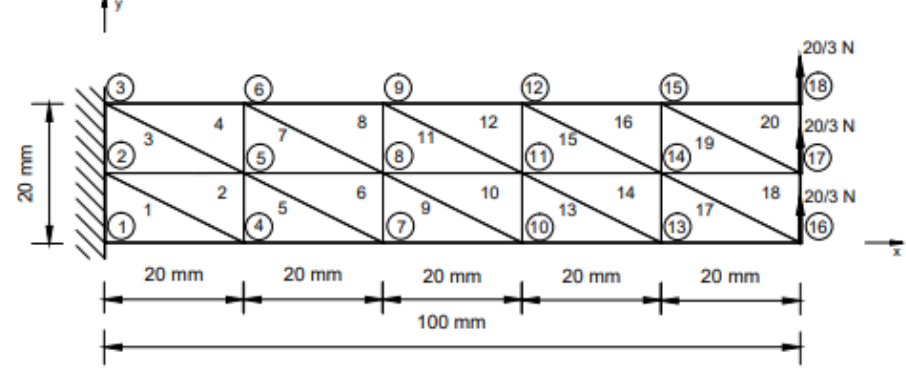
Figure 4. Mathematical model prepared for the analyses of the cantilever beam.